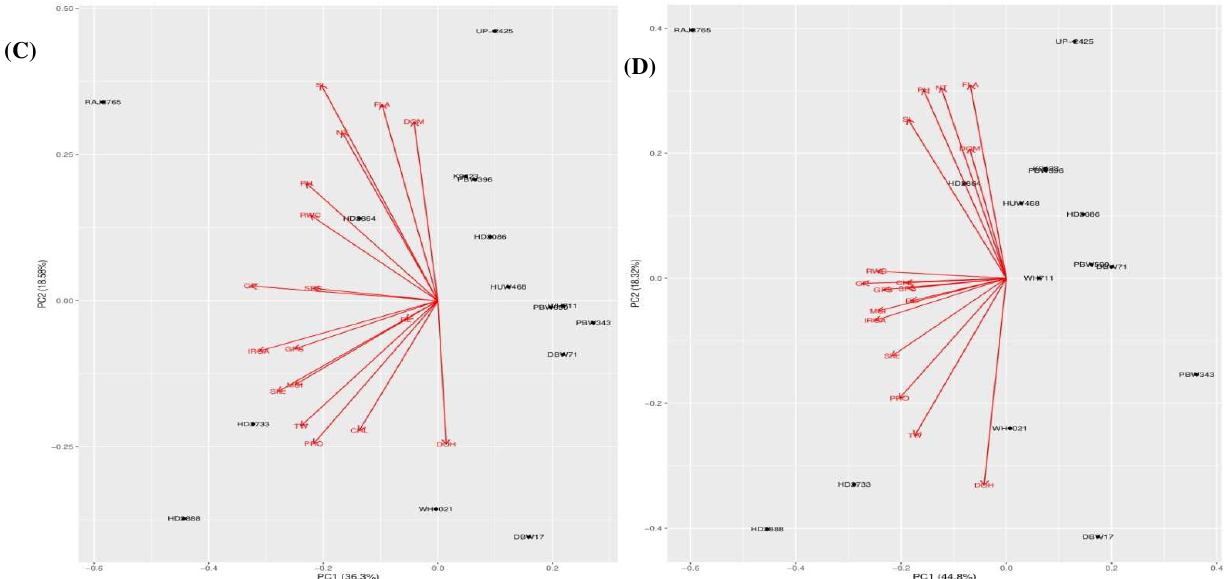
Figure 3. ( A ) Principal component biplot showing genotypic grouping under control conditions. ( B ) Principal component biplot showing genotypic grouping under 5%PEG treatment condition. ( C ) Principal component biplot showing genotypic grouping under 10% PEG treatment condition. ( D ) Principal component biplot showing genotypic grouping under 15% PEG treatment condition. Where Germination count (GC), shoot length (ShL), root length (RL), number of tillers plant −1 (NT), days to heading (DOH), plant height (PH), flag leaf area (FLA), days to maturity (DOM), spike length (SL), spikelet number spike −1 (SPS), number of grain per spike (GPS), Thousand Grain Weight (TW), Photosynthesis rate (IRGA), chlorophyll (CHL), Membrane stability index (MSI) and Relative